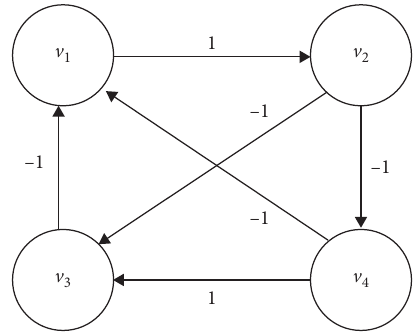
Figure 1: Directed topology which contains a directed spanning tree.